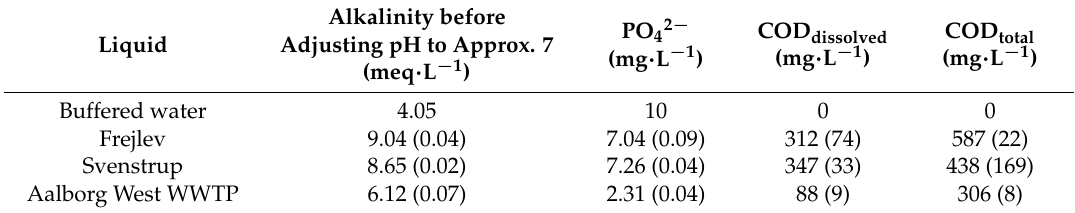
Table 1. Average values (standard deviation) of key parameters characterizing the liquids used. Buffered water was prepared in the laboratory and thus not